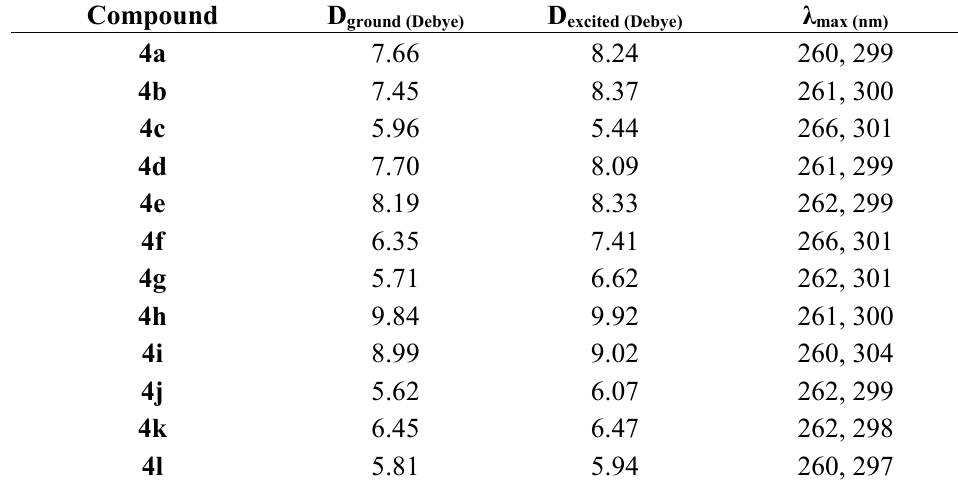
Table 3. The computed dipole moments and absorption spectra of compounds 4a – l .